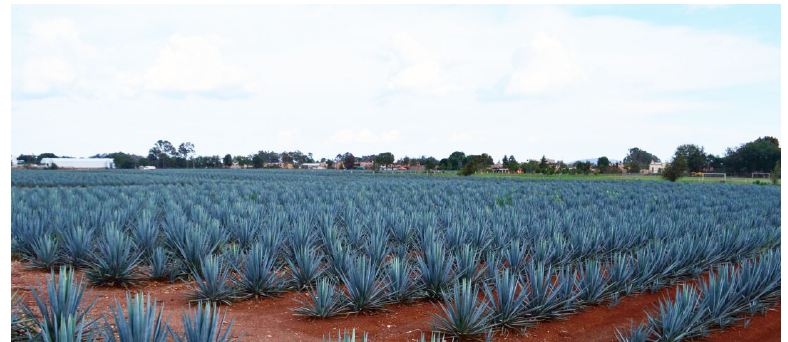
Figure 1. Image of agave plantation: the image is from